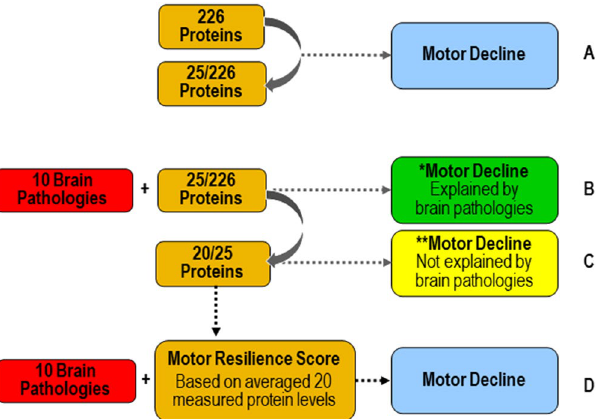
Figure 1. Approach for identifying cortical proteins associated with motor decline unexplained by brain pathologies. Motor decline can be partitioned in to two components. Some but not all of motor decline is explained by the negative effects of brain pathologies (green box) and some is not explained by brain pathologies (yellow box). Cortical proteins associated with motor decline not explained by brain pathologies may